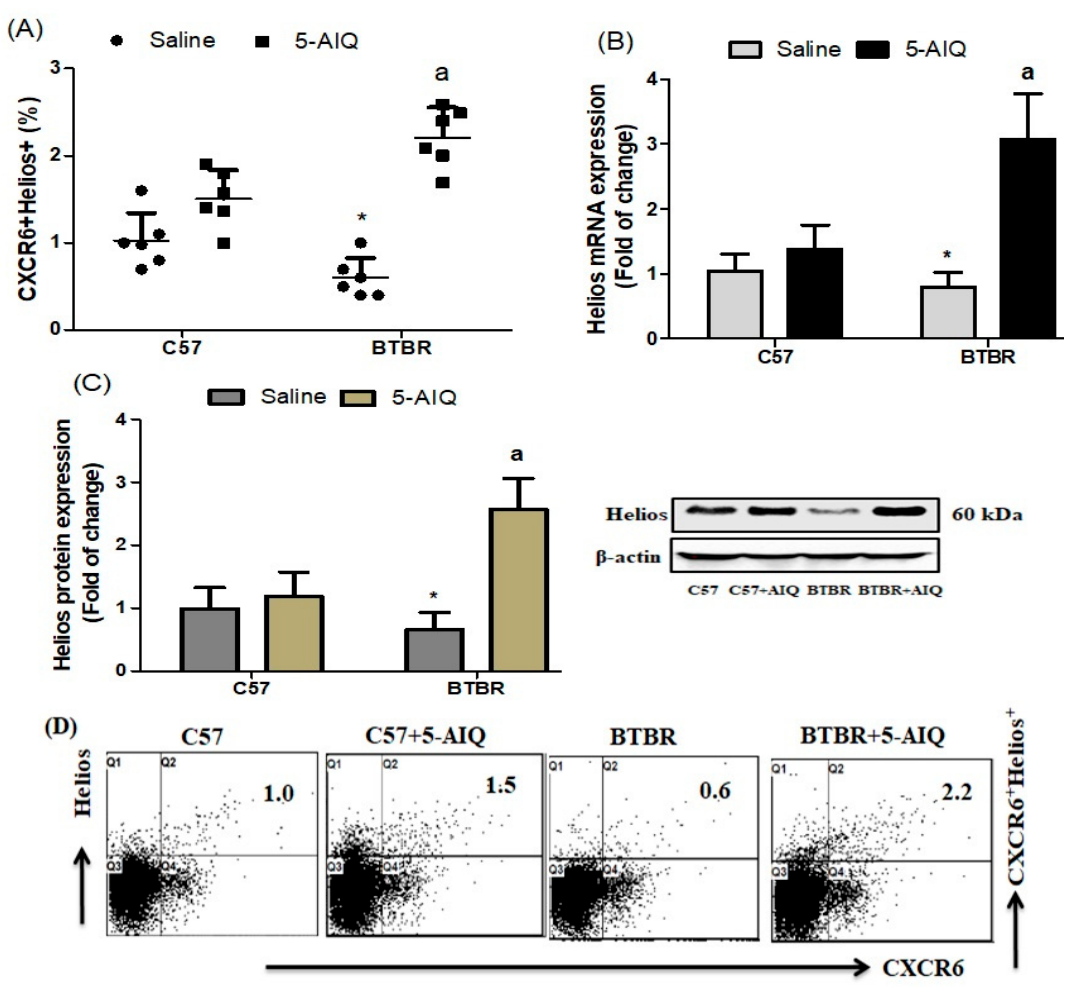
Figure 2. Effects of 5-AIQ on expression of Helios in C57 and BTBR mice. ( A ) Flow cytometry analysis of intracellular Helios-producing CXCR6+ T cells from mouse spleens tissue (Strain effect, F(1,20) = 1.209, p < 0.05; Treatment effect, F(1,20) = 69.48, p < 0.0001, Treatment x Strain effect, F(1,20) = 20.59, p < 0.0002); ( B ) RT-qPCR analysis of levels of Helios mRNA from mouse brain tissue (Strain effect, F(1,20) = 16.41, p < 0.0026; Treatment effect, F(1,20) = 53.77, p < 0.0001, Treatment x Strain effect, F(1,20) = 29.68, p < 0.0001) and ( C ) Western blotting analysis of levels of Helios protein from mouse brain tissue (Strain effect, F(1,20) = 11.79, p < 0.0026; Treatment effect, F(1,20) = 47.47, p < 0.0001, Treatment x Strain effect, F(1,20) = 31.20, p < 0.0001). ( D ) Cells were gated on forward-side scatter dot plots; the dot plots represent the percentages of CXCR6+Helios+ cells. Bar graphs represent the percentage of the CXCR6+Helios+ population. The control C57 and BTBR mice received saline intraperitoneal injection. Treated BTBR and C57 mice received 5-AIQ (1.5 mg/kg) via intraperitoneal injection once daily for ten days. The results are shown as the means ± SD, n = 6, each group; * p < 0.05 compared with saline-treated C57 mice; a p < 0.05 compared with saline-treated BTBR mice.